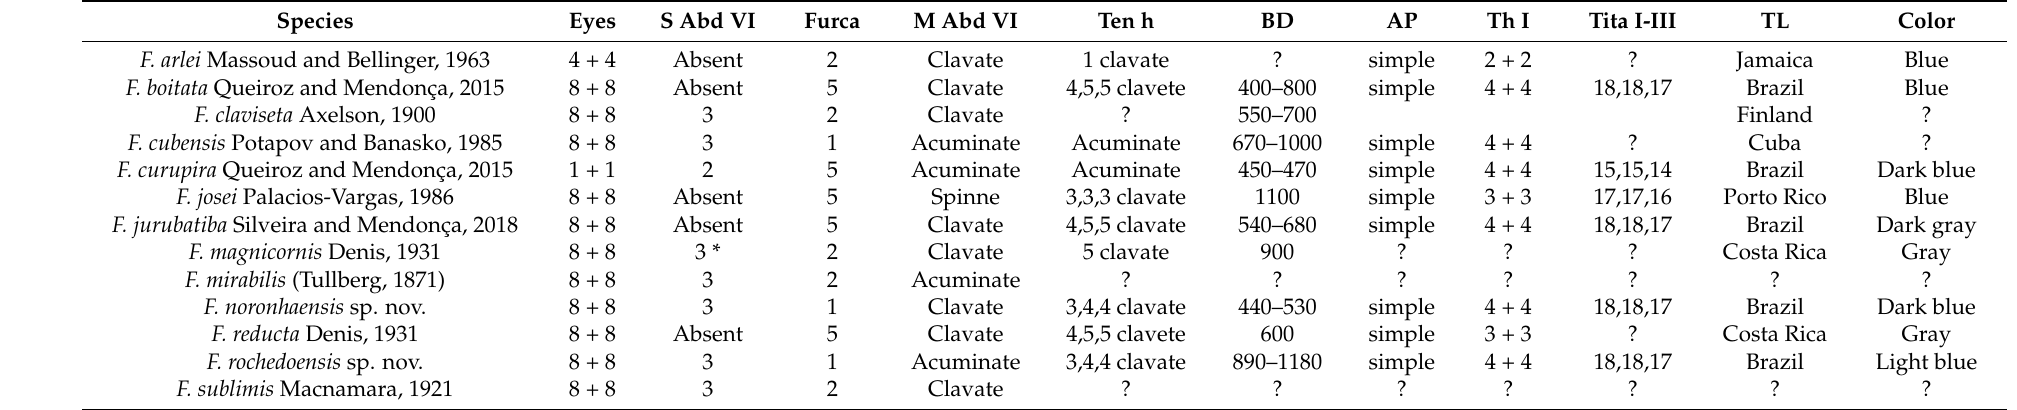
Table 3. Morphological characters of Friesea species record from Brazil. S Abd VI—number of the spine on Abd VI; M Abd VI—modified chaetae on Abd VI; Ten h—tenent hair; BD—body length in µ m; AP—apical vesicle; TL—type locality; “?”—missing date; number in Furca column refers of furca “State” according to